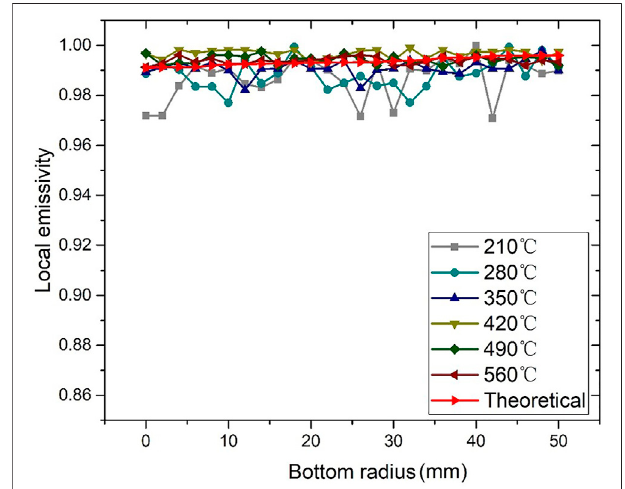
FIGURE 9 | Comparison of theoretical and measured emissivity.